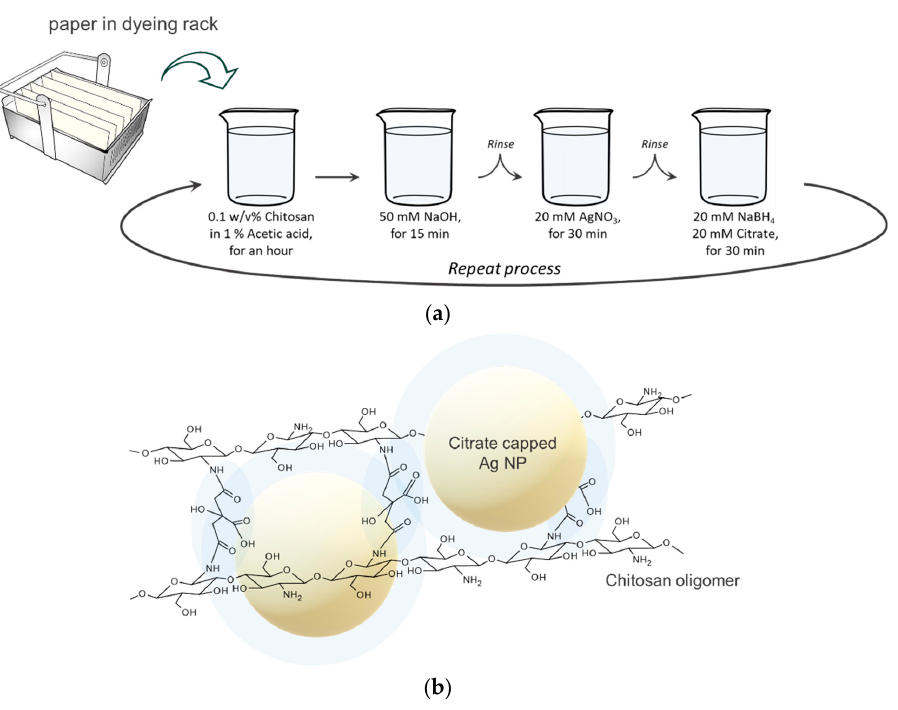
Figure 1. ( a ) Schematic illustration of the layer-by-layer process used to coat cellulose paper with silver/chitosan nanocomposite, where the paper substrate was submerged in each reagent solution, stepwise; ( b ) Configured silver/chitosan nanocomposite by coordinate bonds between citrate-capped silver nanoparticles and self-assembled chitosan.